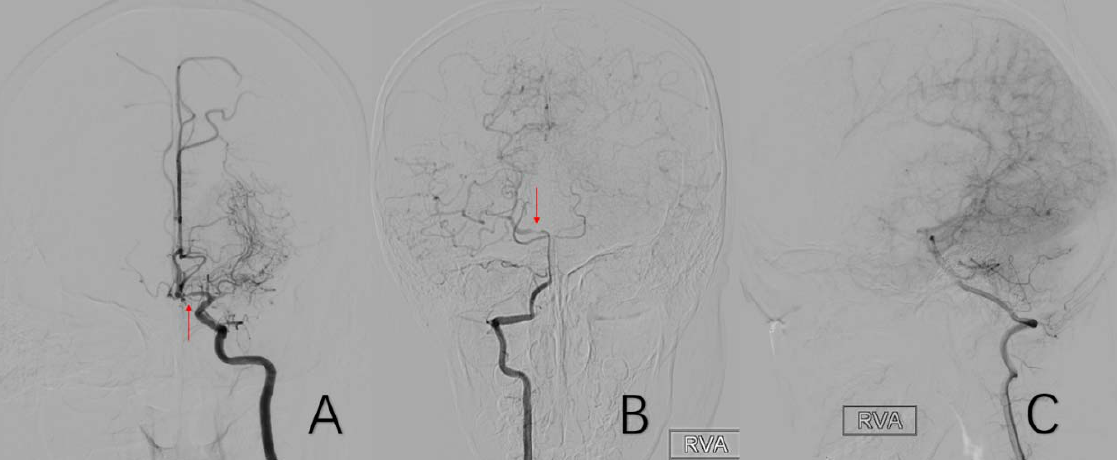
Figure 9. ( A ) is a 54-year-old male who had left A1 stenosis while supplying the right anterior cerebral artery A2 and distal branches vicariously through the anterior communicating artery. ( B , C ) are the same 8-year-old male. He had localized stenosis of the right P1 and a compensatory blood supply from the right posterior cerebral artery to the anterior cerebral artery and middle cerebral artery. The red arrow in ( A ) shows the location of A1 stenosis. The red arrow in ( B ) shows the location of P1